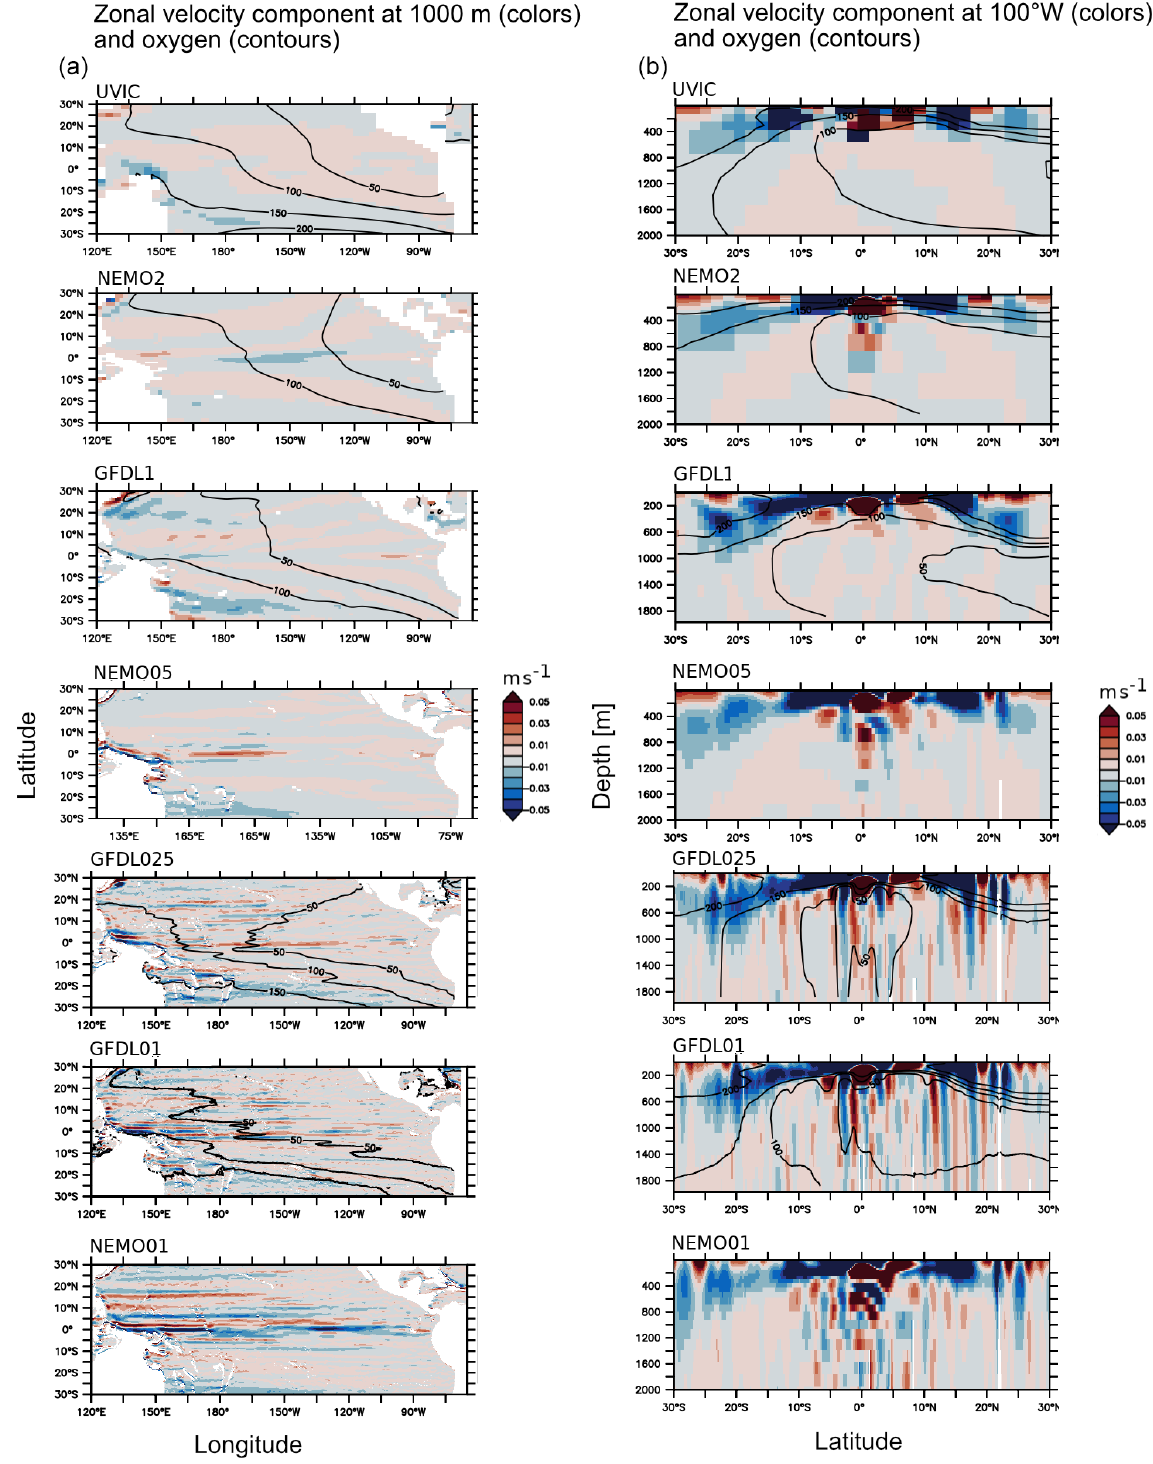
Figure 5. Mean current velocity (ms − 1 ) at (a) 1000m of depth at (b) 100 ◦ W in UVic, NEMO2, NEMO05, GFDL025, GFDL01, and NEMO01. The mean oxygen levels (mmolm − 3 ) (when coupled circulation–biogeochemical experiments have been performed; see Table 1) are displayed as a